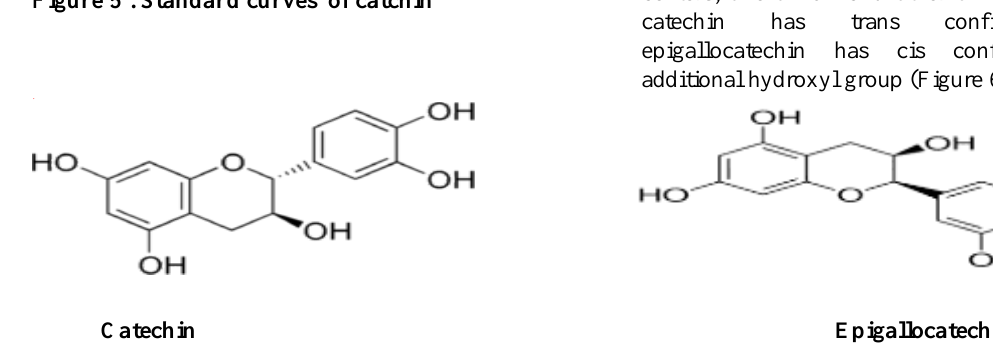
Figure 5 . Standard curves of catchin